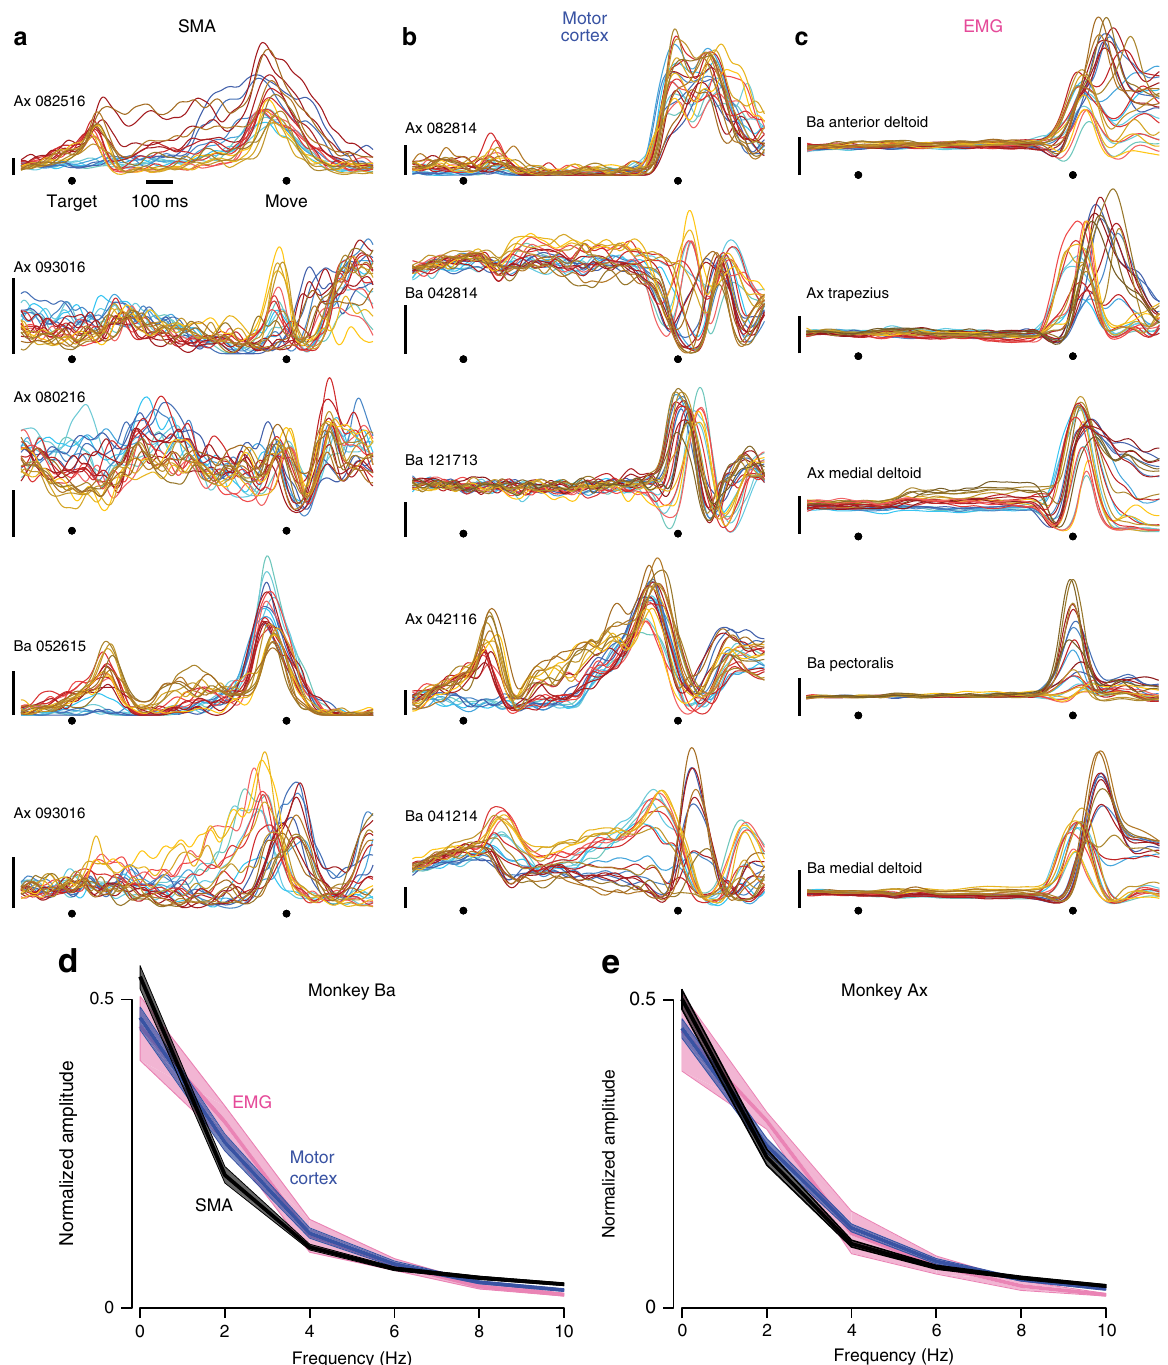
Fig. 2 Example responses of single neurons and muscles. a Example responses of fi ve neurons recorded from SMA. Each colored trace plots the trial- averaged fi ring rate for one condition, computed as illustrated in Fig. 1. Red, blue, and yellow traces correspond to the three contexts. Darker/lighter traces are for reaches to the left/right. (Same color scheme as in Fig. 1a, b). Scale bars indicate 20 spikes/s. b Same as a , but for fi ve neurons recorded from motor cortex. c Same as a and b , but for fi ve example muscle recordings. The bottom of the vertical scale bars indicates zero EMG activity, but the scale is otherwise arbitrary. d Frequency spectrum, computed via the Fourier transform, for the three populations. Frequency content was computed per neuron/ muscle, over the temporal interval from − 250 to 250 ms relative to movement onset. Frequency content was then normalized and averaged. Envelopes show 95% con fi dence intervals computed via bootstrap, resampling neurons/muscles. Data are for monkey Ba. e Same as d , but for monkey (Fig. 1f, magenta trace) was then computed just as for the estimates thus tended to be slightly noisier for SMA. Otherwise, neurons. single-neuron responses were in many ways similar (Fig. 2a, b). On average, fi ring rates were higher in motor cortex: peak For both areas, fi ring rates varied with reach direction before and fi ring rate averaged 75 and 77 spikes/s (monkey Ba and Ax) during movement (darker/lighter traces correspond to leftwards/ versus 43 and 53 spikes/s for SMA. Individual-neuron fi ring rate rightwards reaches). During movement, responses often exhibited